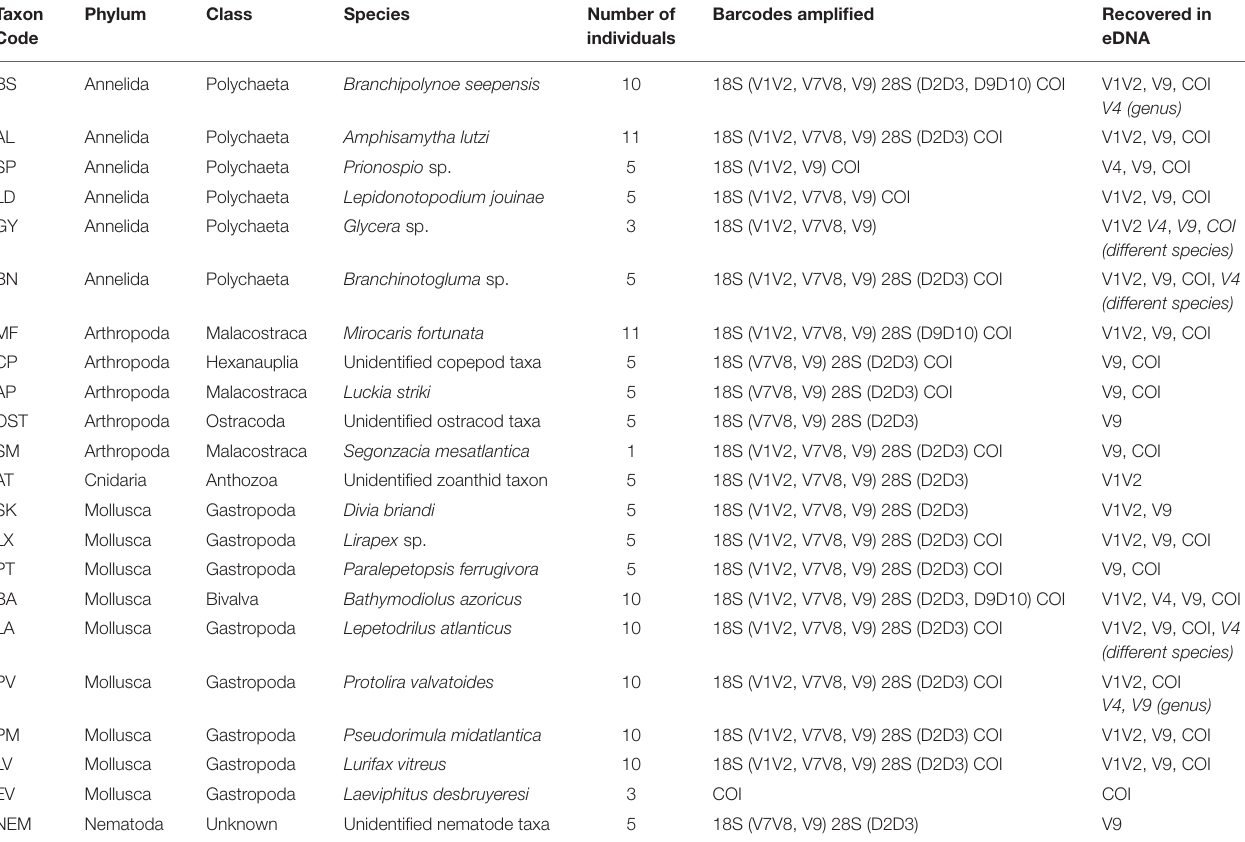
TABLE 2 | DNA barcode inventory for 22 taxa collected from the Montségur